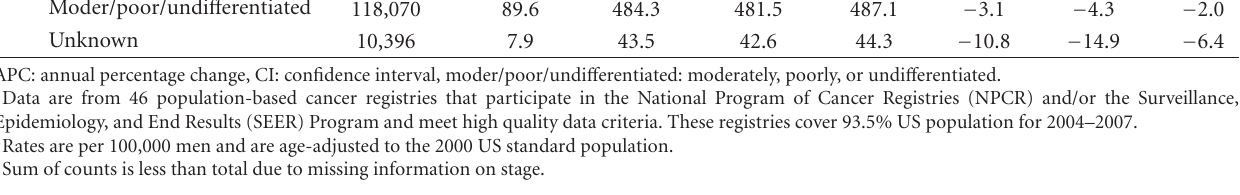
Table 3: Incidence rates and annual percentage changes in rates for prostate cancer by cancer stage and grade, US men,